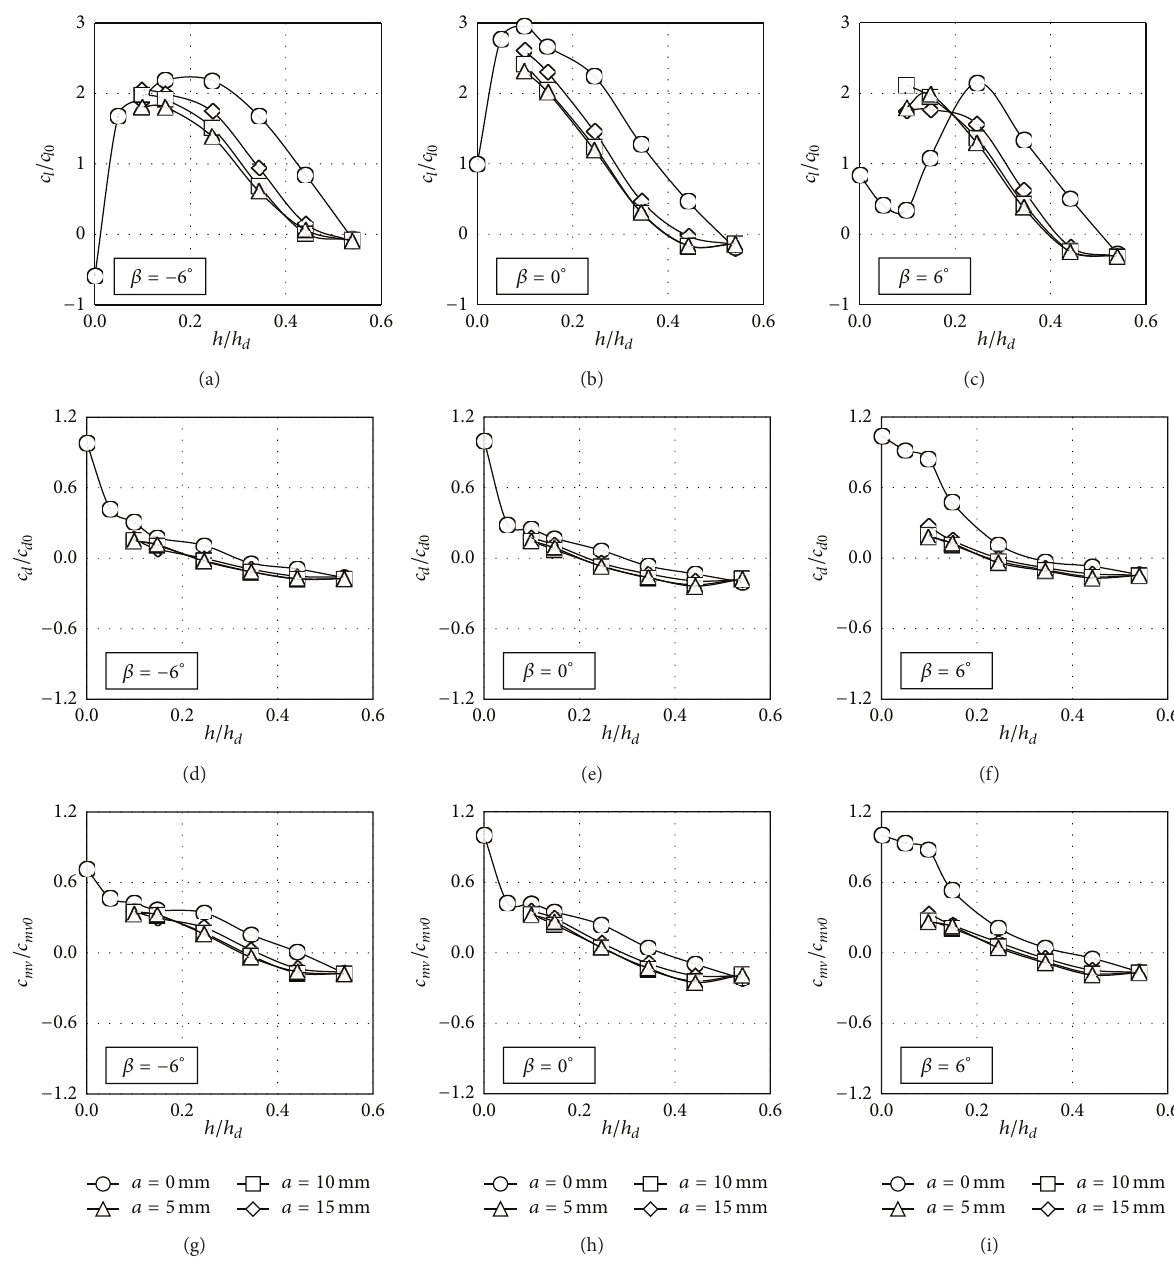
Figure 13: Lift, 𝑐 𝑙 /𝑐 𝑙0 , side force, 𝑐 𝑑 /𝑐 𝑑0 , and rolling moment, 𝑐 𝑚 V /𝑐 𝑚 V 0 , coefficient ratios as a function of the windbreak height, when the train coach is placed on the windward rail on the embankment with slope 1: 1. Four eave lengths are considered, 𝑎 = 0 mm (circles), 𝑎 = 5 mm (rhombi), 𝑎 = 10 mm (squares), and 𝑎 = 15 mm (triangles). Each column represents a different coach rolling angle, 𝛽 = −6 ∘ (left), 𝛽 = 0 ∘ (centre), and 𝛽 = 6 ∘